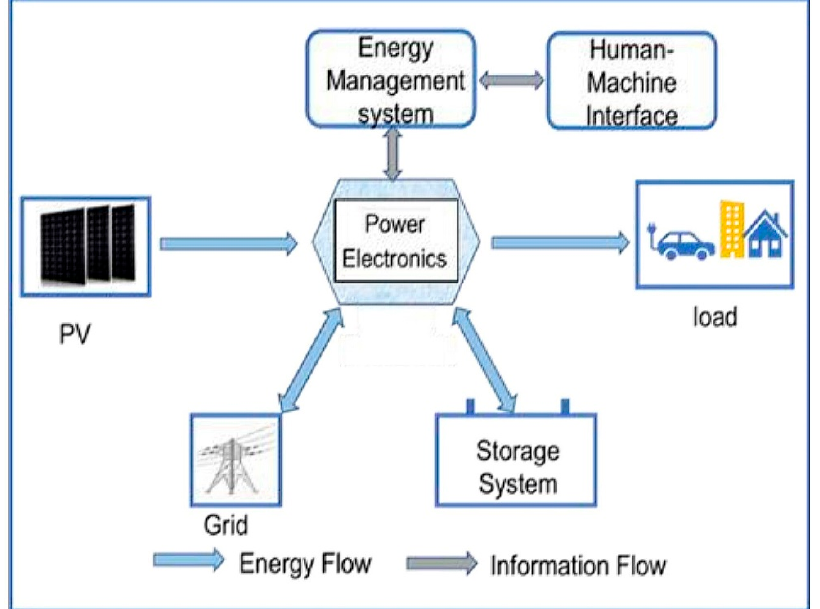
Figure 6. Microgrid